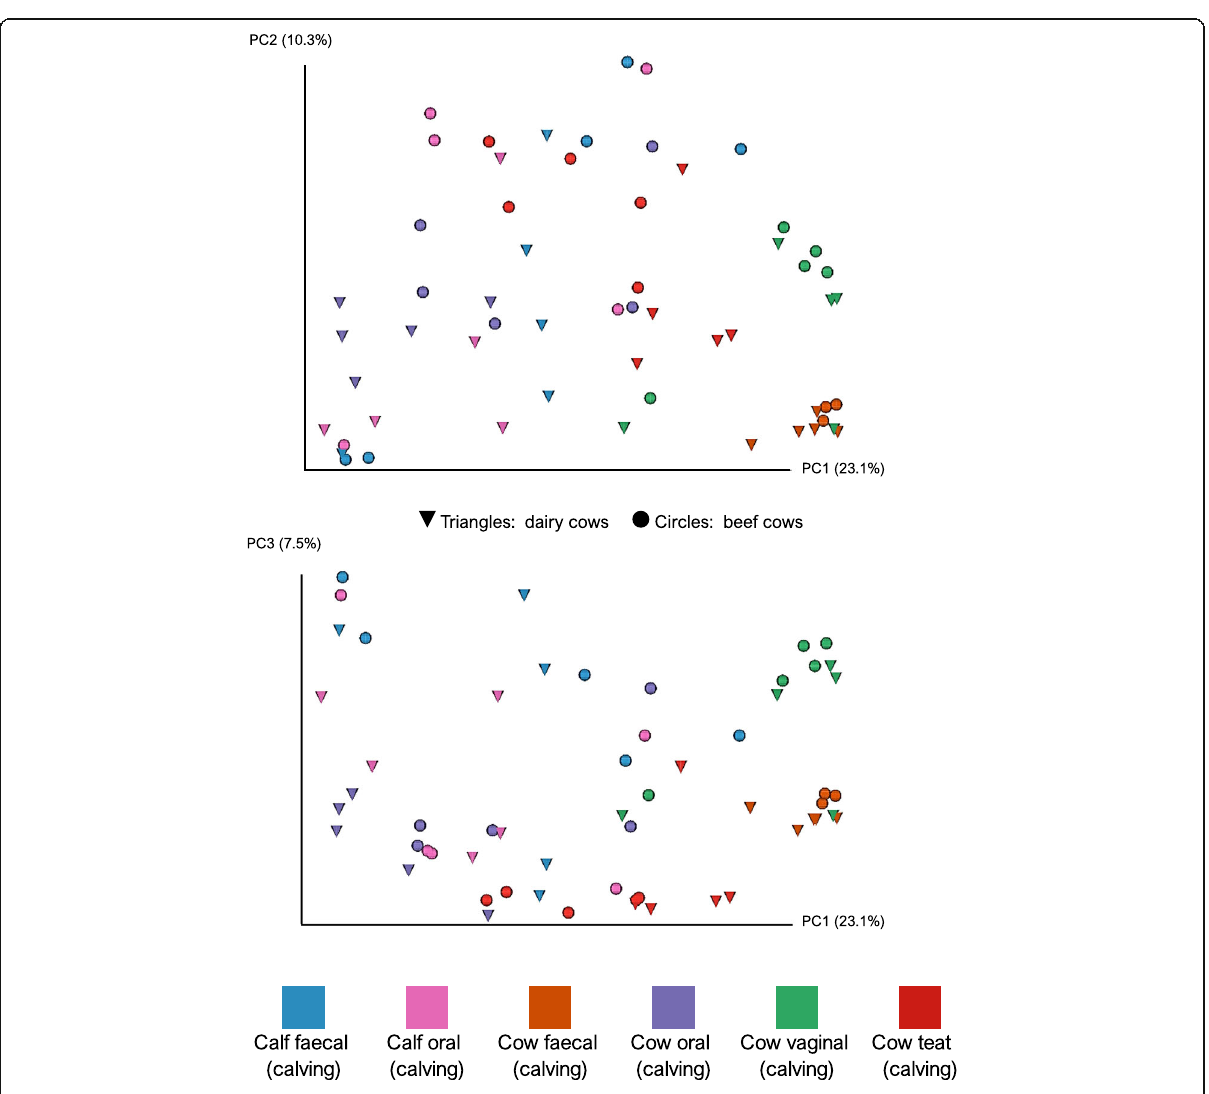
Fig. 3 Principal Coordinate Analysis (PCoA) of unweighted UniFrac distances at Calving. Beef animals are represented by circles and dairy animals by triangles. The “ Calving ” timepoint is up to 12 h after parturition. The two plots display the same data but with different y-axes to display the three-dimensional relationship between datapoints. The number of individual animals in each group: N =